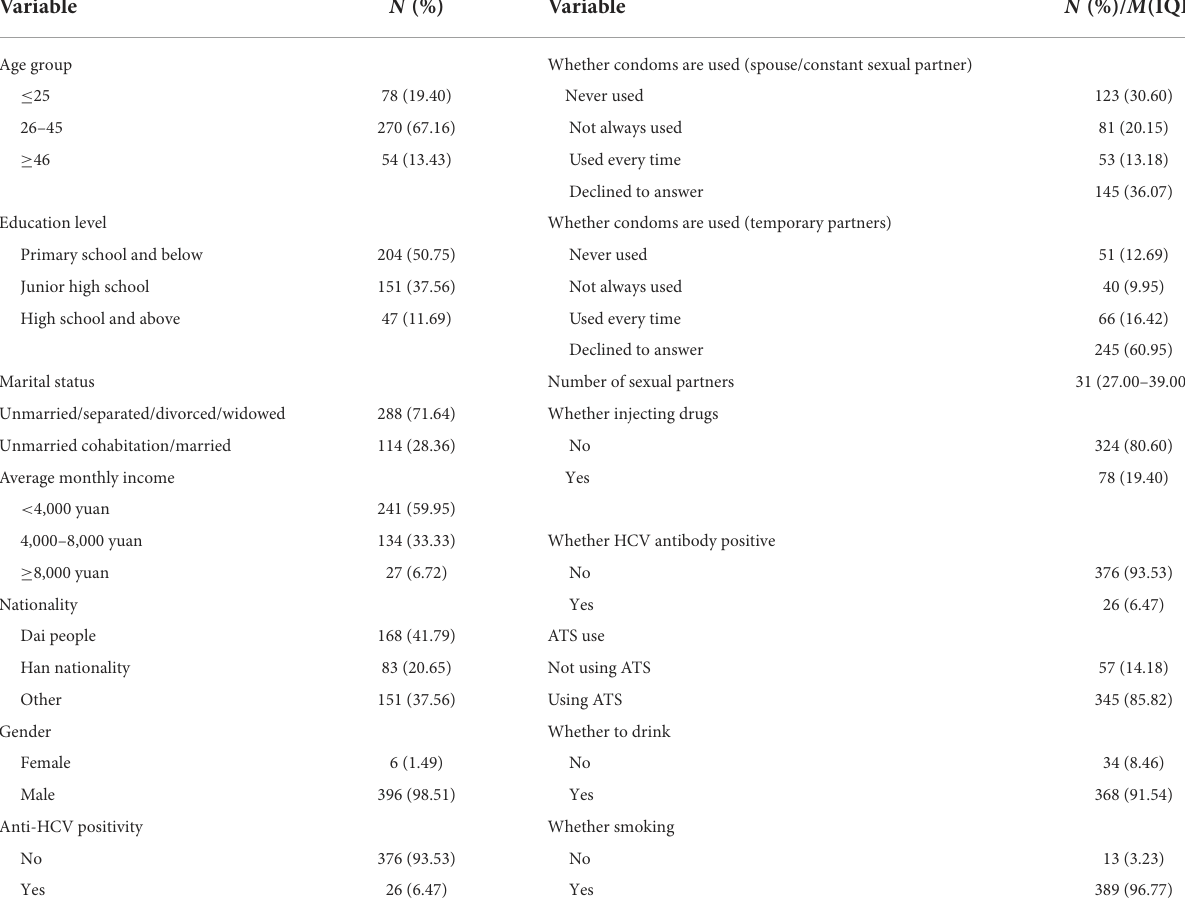
TABLE 1 Demographic characteristics among drug users ( N =